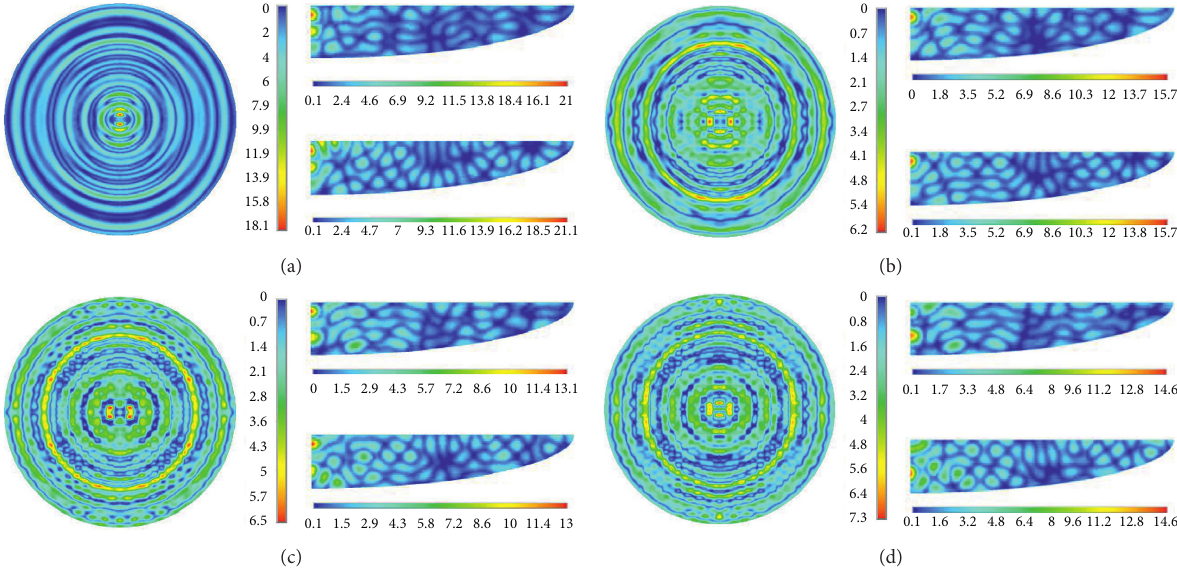
Figure 11: The displacement amplitude of the homogeneous sedimentary basin ( f � 5.0Hz): (a) no buildings; (b) buildings 14 × 14; (c) buildings 20 × 20; (d) buildings 26 ×